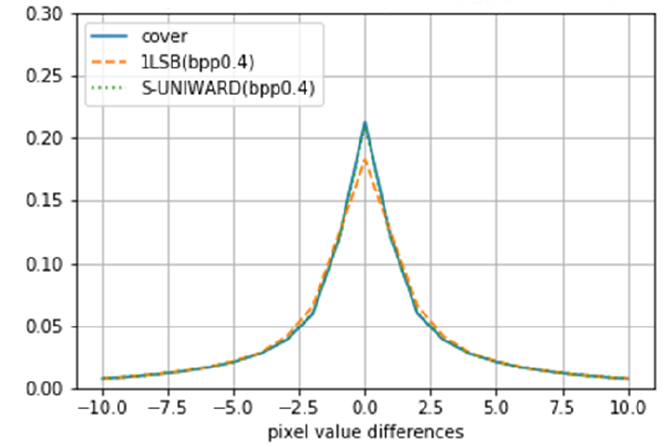
Figure 1. Probability density functions of the differences between the adjacent pixels on a cover image and its stego